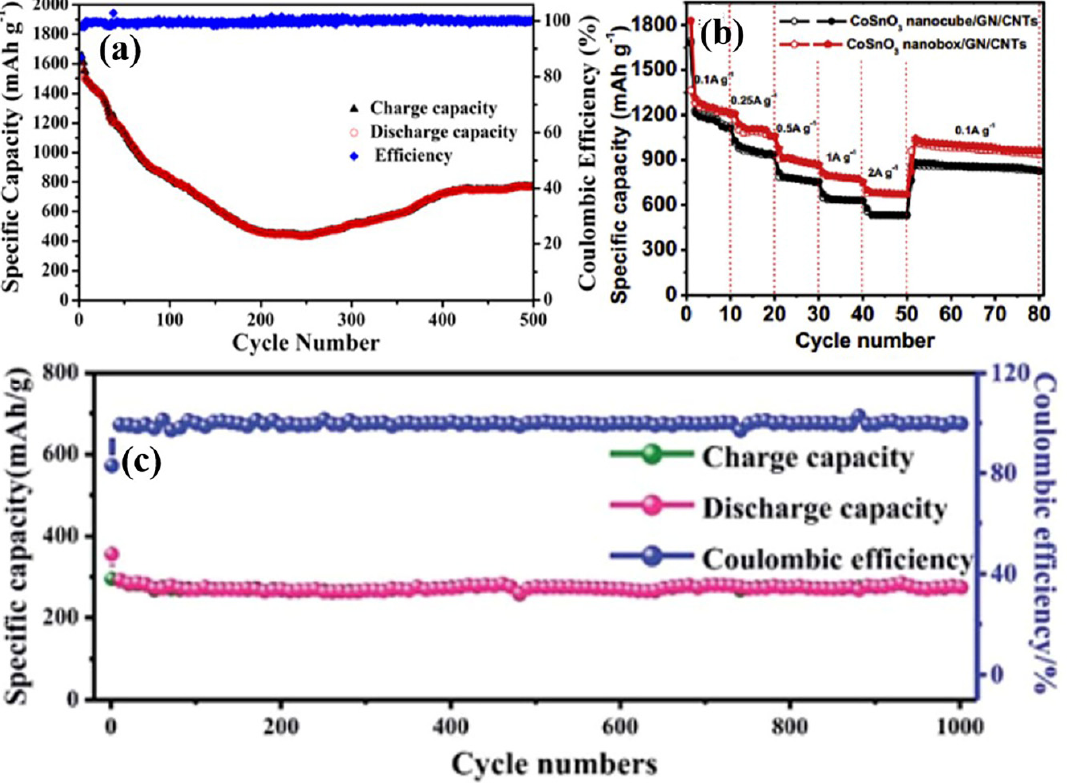
Figure 14. Electrochemical performances of cobalt-based anode materials. ( a ) Cyclic performance of CoMn 2 O 4 microspheres at 100 mA g − 1 in LIBs [51]. ( b ) Rate performance of CoSnO 3 nanobox / graphene (GN) / carbon nanotubes (CNTs) and CoSnO 3 nanocube / GN / CNTs as anode materials of LIBs [109]. ( c ) Cyclic properties of CoSnO 3 -N doped C (NC)-120 at 1 A g − 1 [52].